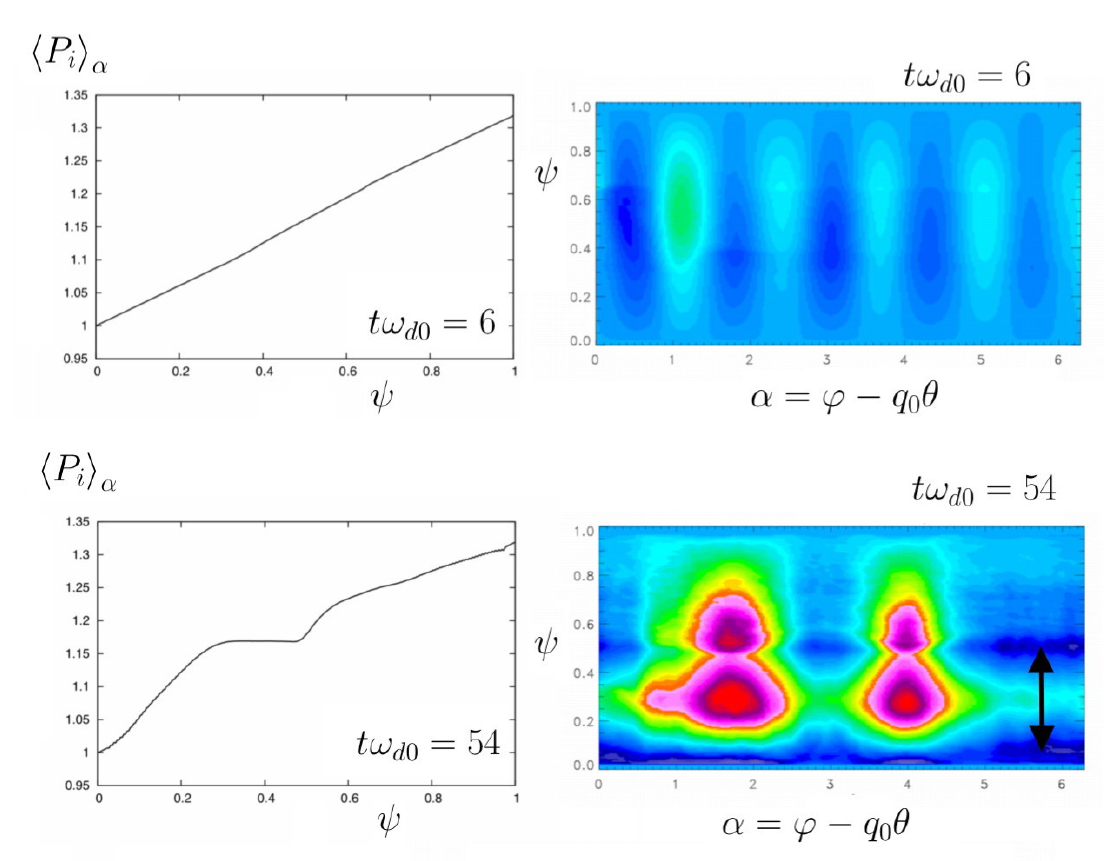
Figure 7. Continuing the results of simulation shown previously in Figures 4–6, we have plotted the mean ion pressure (cid:104) P i (cid:105) , displayed on the left panel, as a function of the poloidal flux ψ and α the corresponding electric potential representation on the right panel, showing the formation of a transport-barrier region (located around ψ ∼